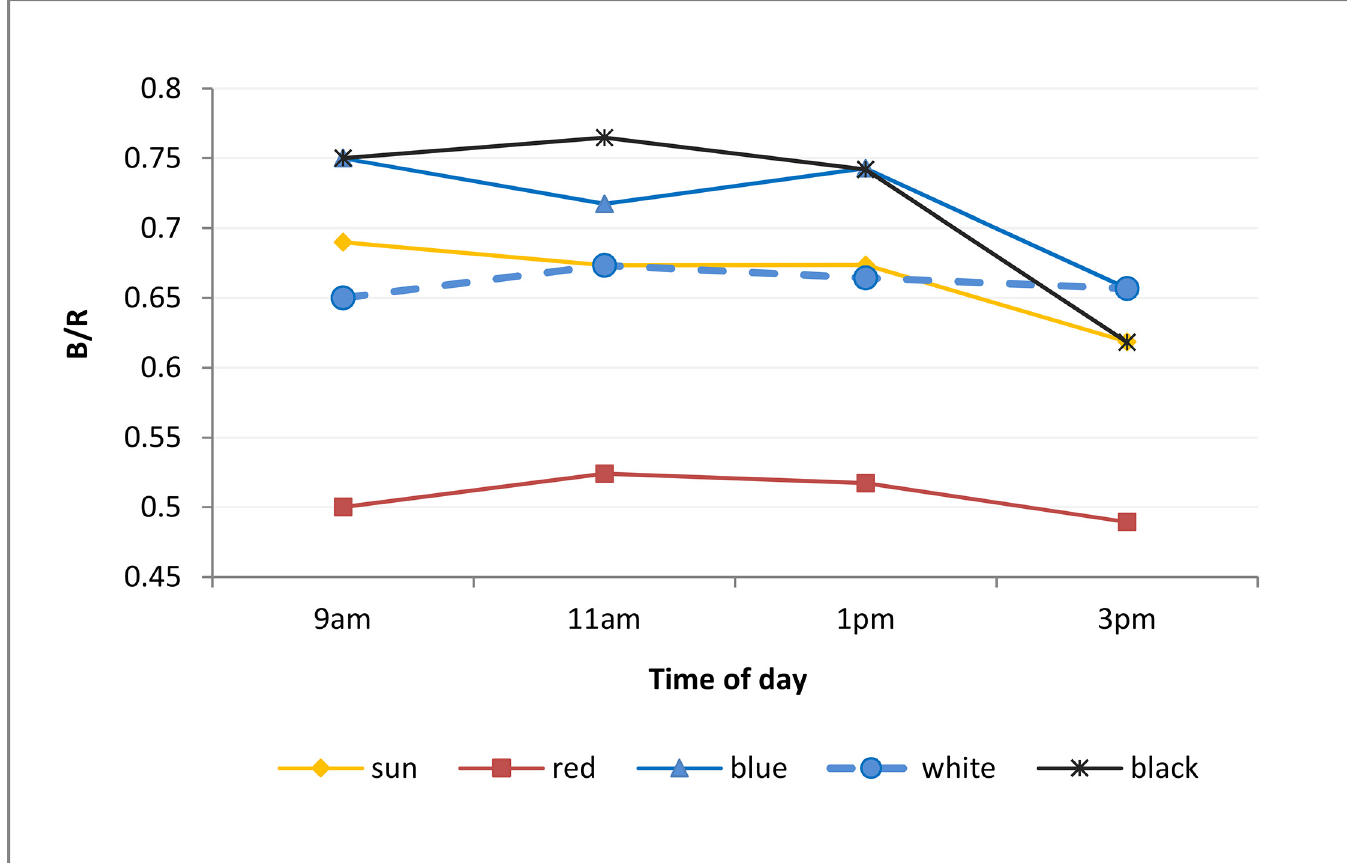
Fig 3. Ratios of blue/red (B/R) components of visible light spectrum were measured during daytime under clear sky day (June 30,